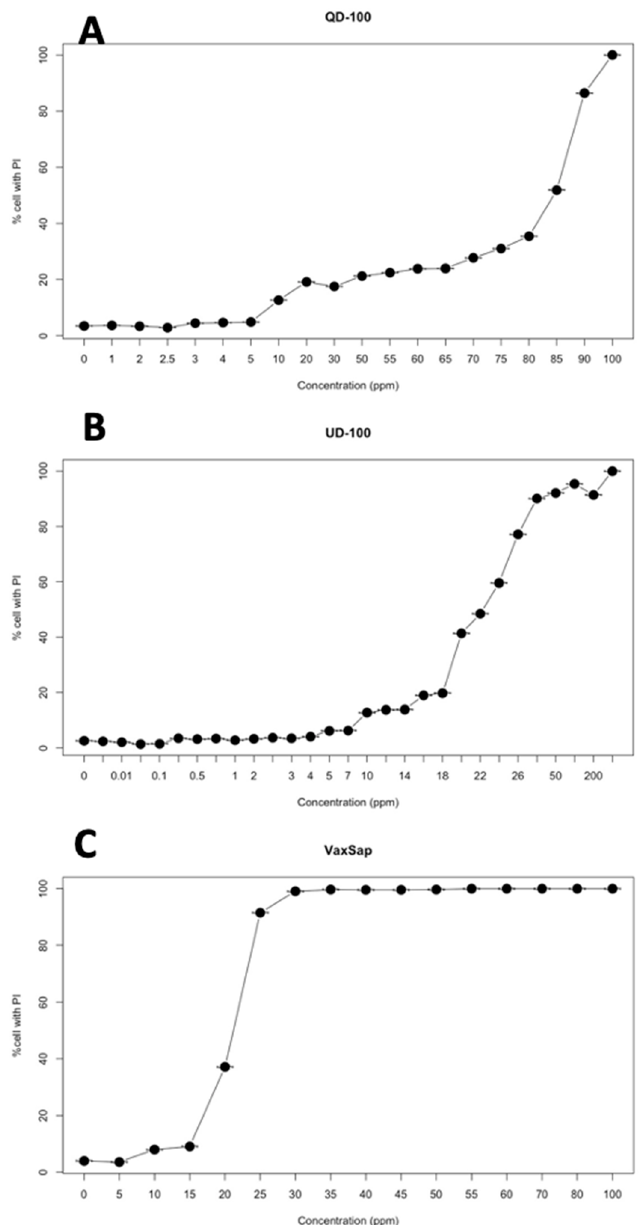
Figure 1. Cytotoxicity curves of quillaja extracts on SHK-1 cell culture: ( A ) QD 100; ( B ) UD100-Q; ( C ) VaxSap.